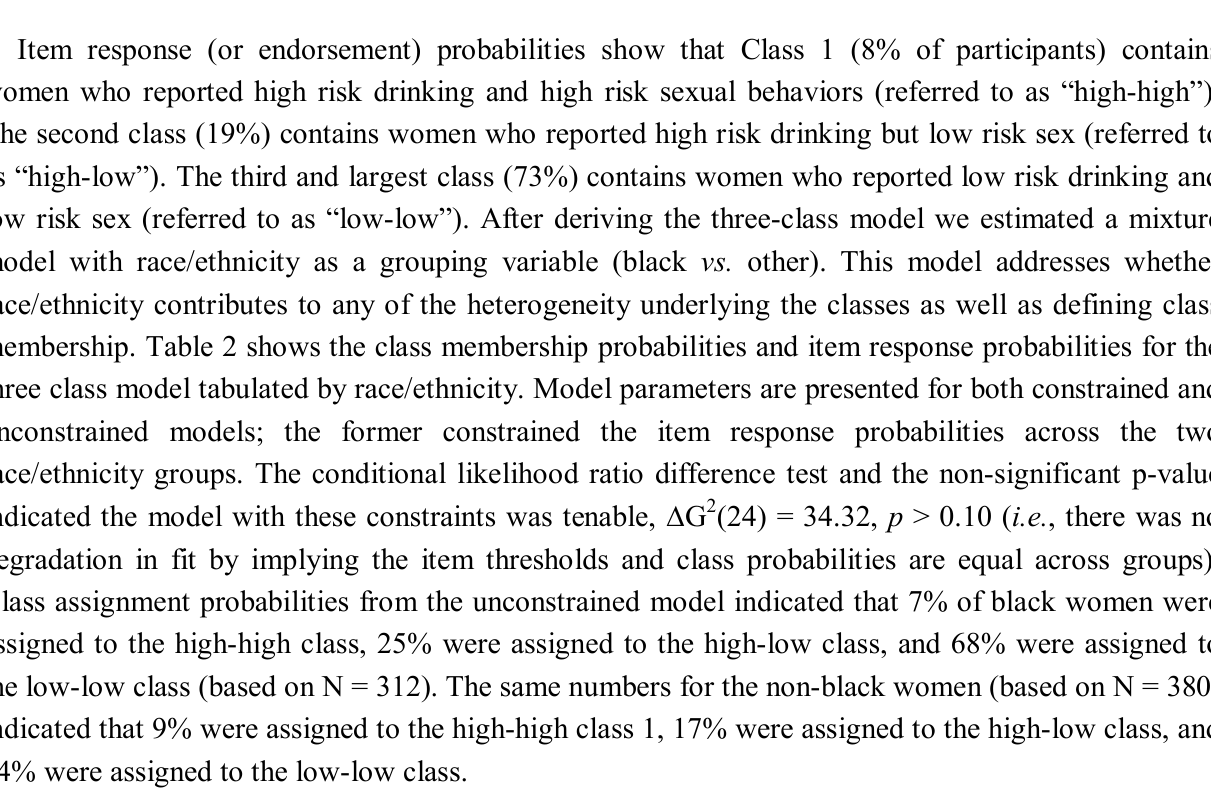
Figure 1. ( a ) Item response probabilities by class membership among black women; ( b